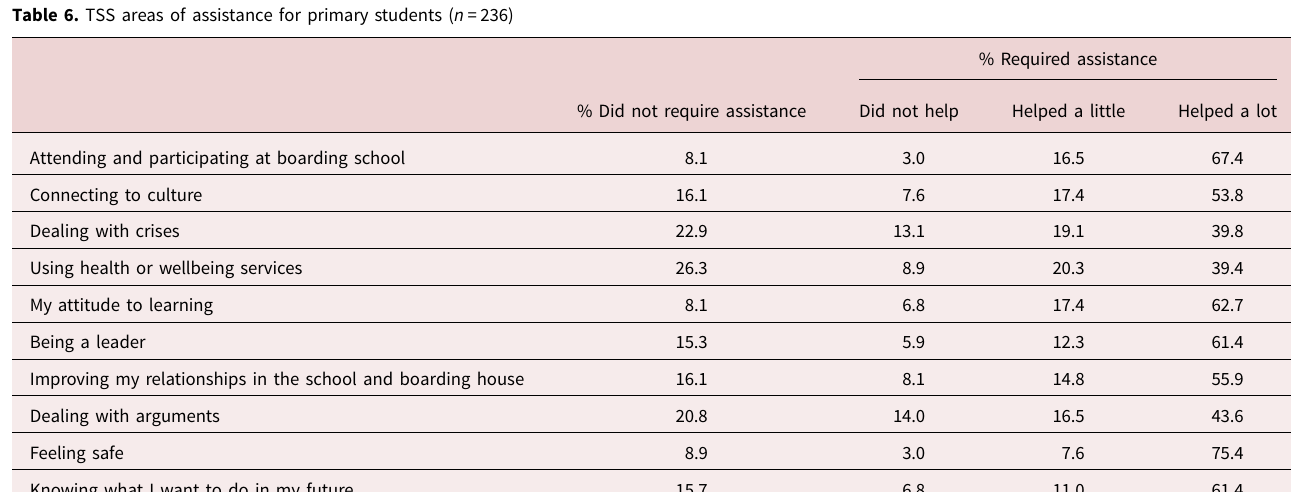
Table 6. TSS areas of assistance for primary students ( n =236)